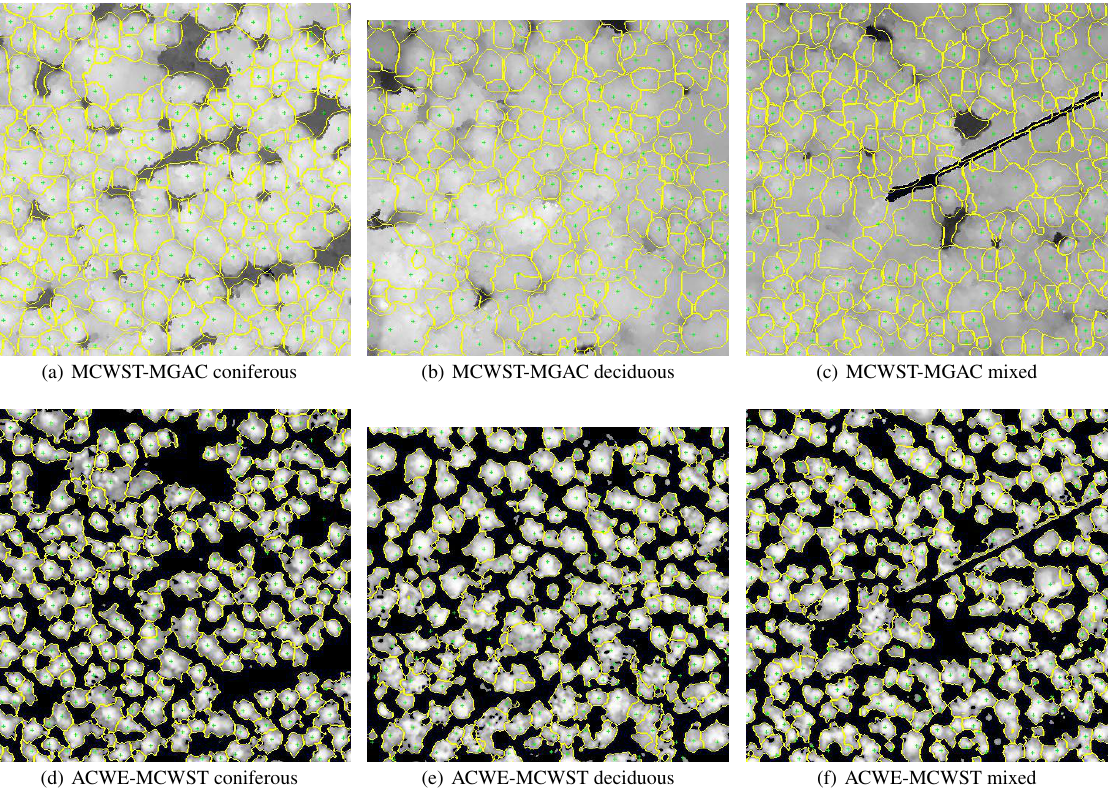
Figure 7. Segmentation results overlaid with groundtruth. The upper/lower row show the final boundaries of MCWST-MGAC / ACWE-MCWST for each of the test plots in yellow. The groundtruth tree trop markers are displayed as green